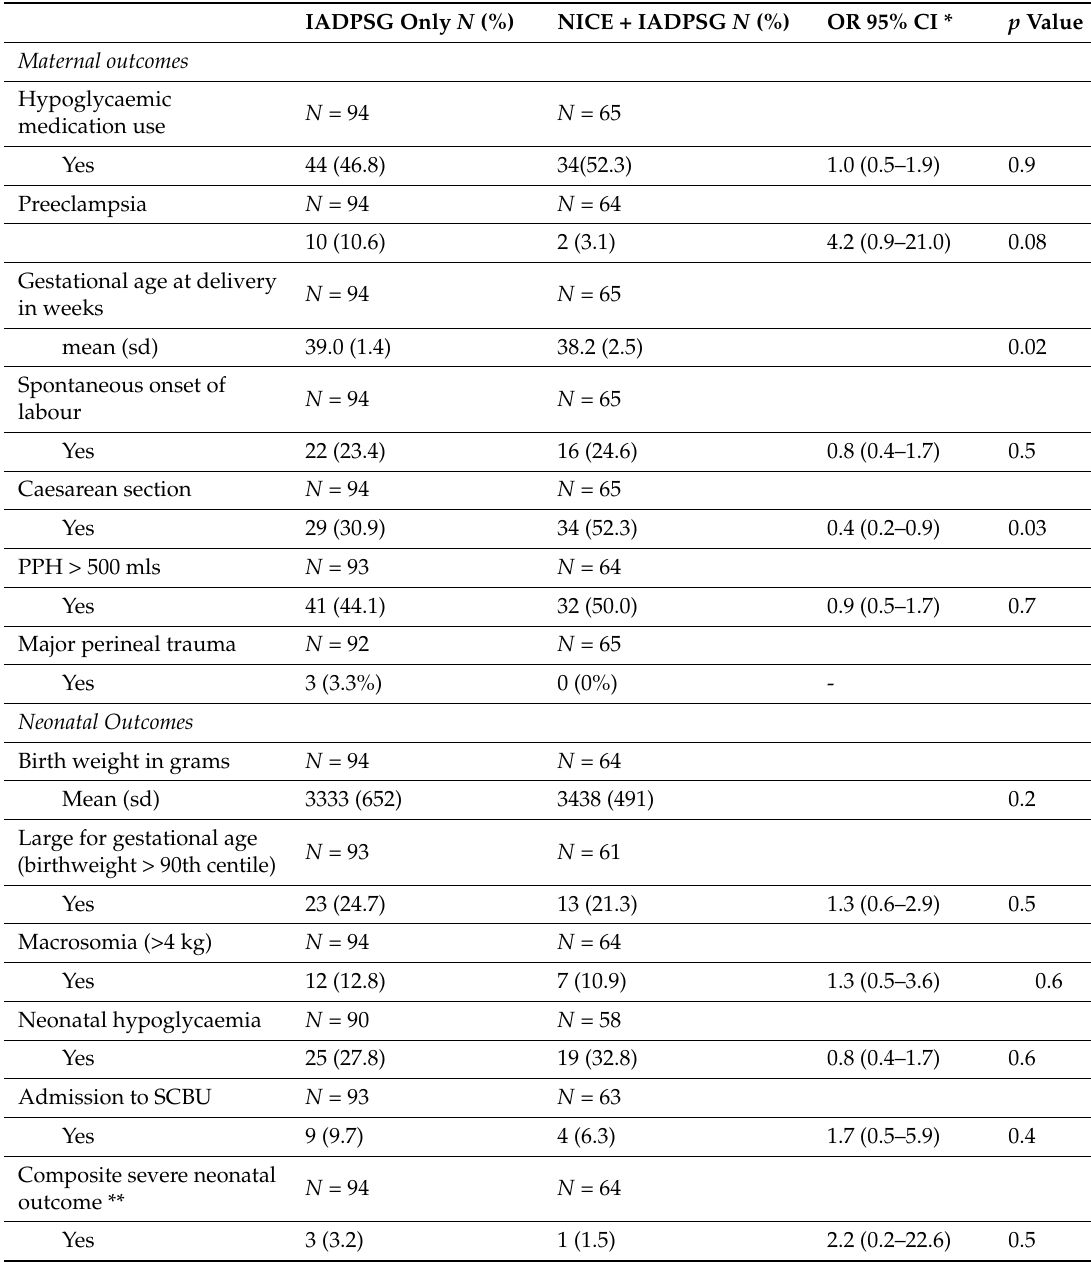
Table 3. A comparison of maternal and neonatal outcomes in women with GDM identified by NICE or IADPSG